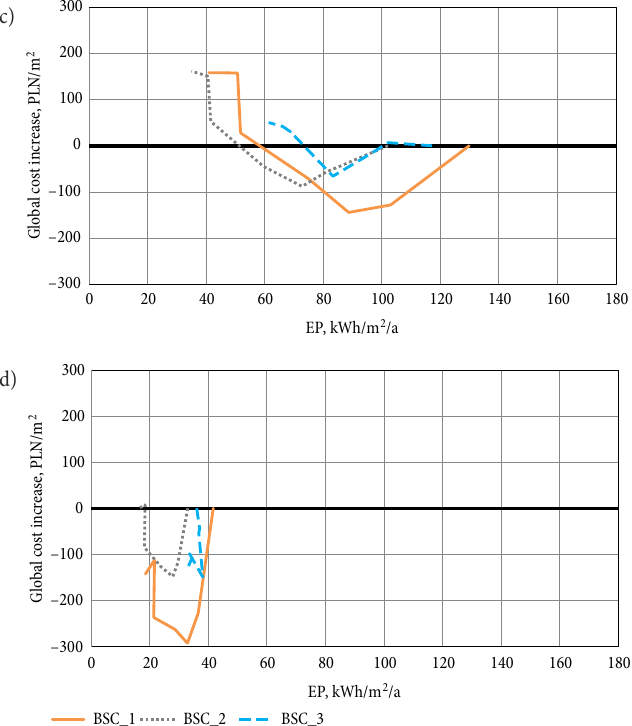
Fig. 3. The absolute change in global costs in relation to the TV_1 technical variant for the analysed buildings and the different heat sources, kWh/m 2 /a: a – GCB; b – DH; c – GHP; d –